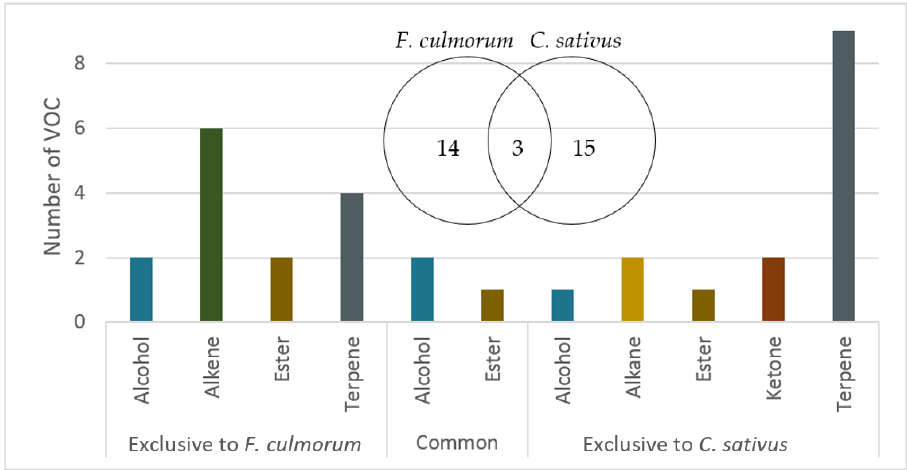
Figure 3 . Number of VOCs emitted by F. culmorum and C. sativus distributed by chemical family (independent of the two culture conditions) .